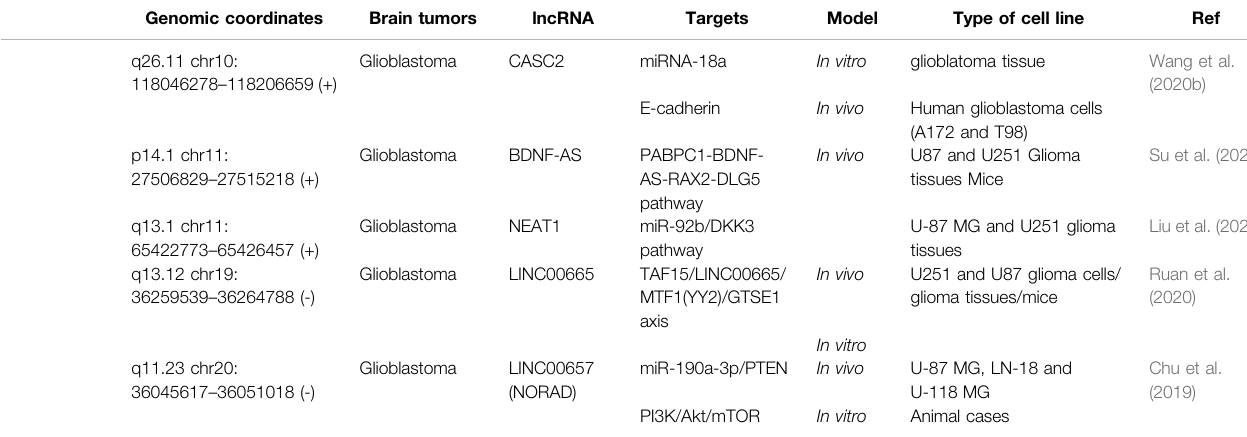
TABLE 2 | ( Continued ) Apoptosis-related lncRNAs in brain tumors.